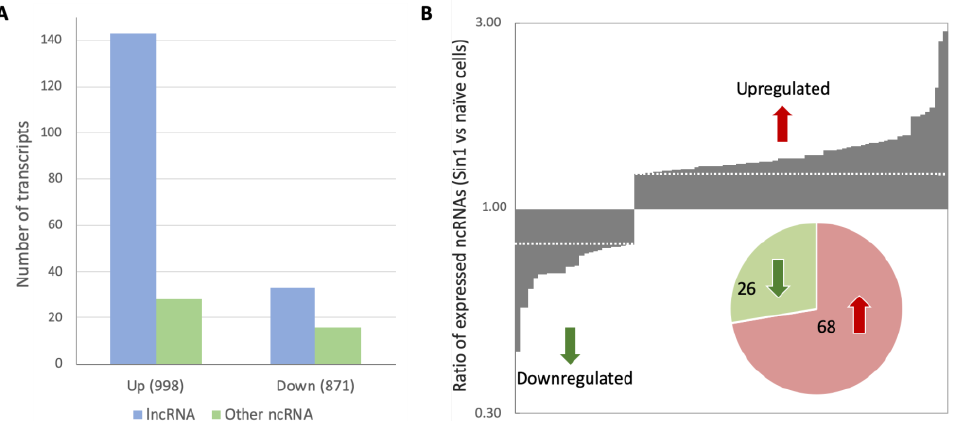
Figure 3. Differentially expressed (DE) ncRNAs following 24 h of exposure to Sin1 relative to untreated cells. ( A ) Transcripts associated with upregulation (Up) and downregulation (Down) relative to naïve, untreated cells. The number of genes associated with each expression trend is shown in parentheses. The rest of the genes (9719 genes) were unchanged. See the Materials and Methods for the expression trend definition. ( B ) Histogram showing the DE ncRNAs ratio for downregulated and upregulated transcripts. The dashed line marks the expression ratio (1.25 and 0.8) vs. naïve cells for Up and Down, respectively. The pie diagram applies to 94 genes that satisfy the threshold.